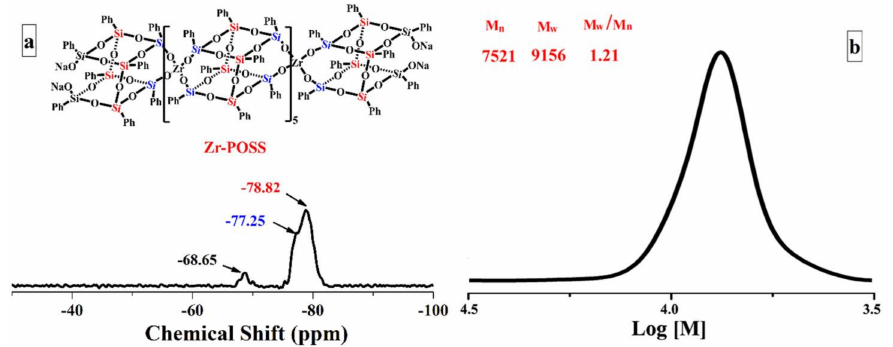
Figure 3. 29 Si-NMR ( a ) and GPC elution ( b ) curve of Zr-POSS.